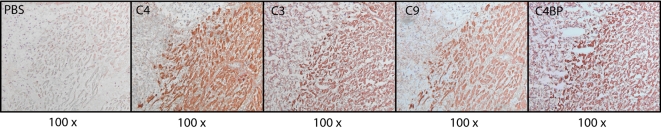
C4, C3b and C9 are also present on the affected tissue.Representative pictures of consecutive sections of heart tissue of an AMI sample stained for C4, C3b, C9 and C4BP or with secondary antibody only (PBS).